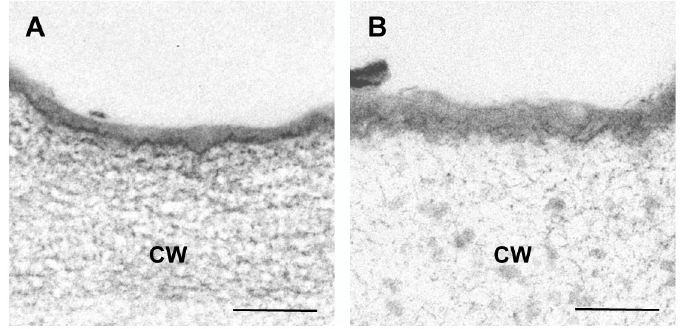
Fig 5. Cuticular structure in diploid and tetraploid dark-grown hypocotyls as assessed by transmission electron microscopy. Transmission electron micrographs of cuticle in epidermal cells derived from the apical 3 mm region of 7-day-old dark-grown hypocotyl of diploid (A) and tetraploid (B) seedlings. CW, cell wall; 2x, diploid plants; 4x, tetraploid plants. Bars = 100 nm.